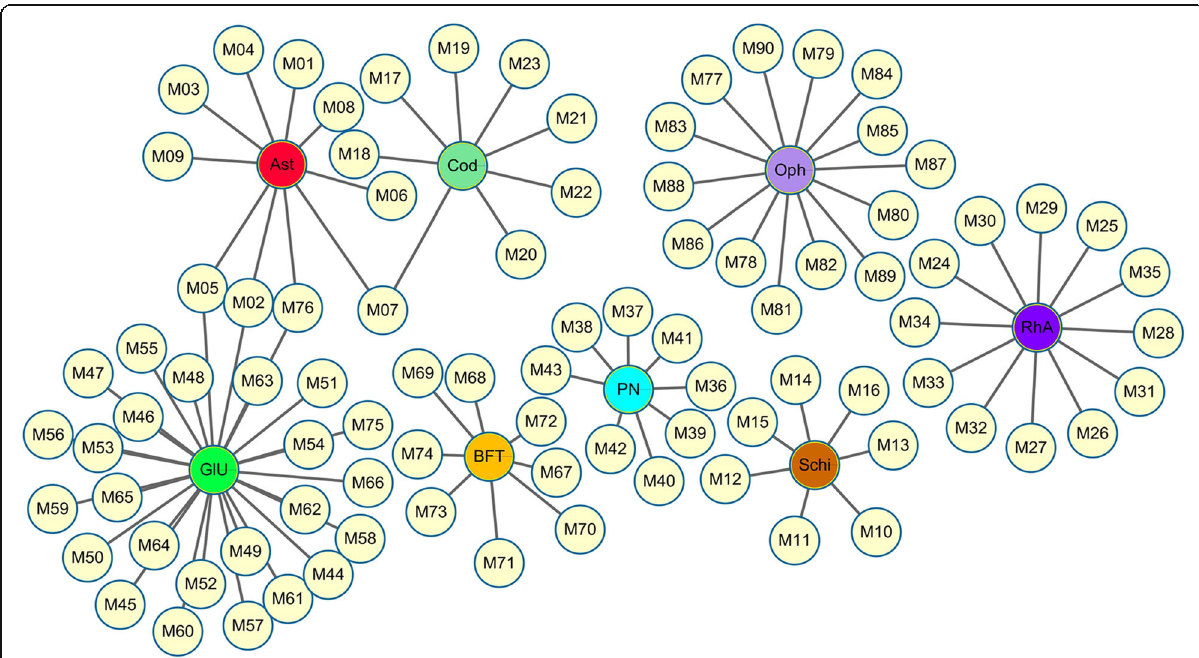
Fig. 4 Compound – medicine network. Yellow circular nodes represent the effective chemical compounds from eight herbs in FFK. Rectangle nodes indicate the following herbs: Astragalus membranaceus (Ast), Codonopsis pilosula (Cod), Ophiopogon japonicus (Oph), Schisandra chinensis (Schi), Panax notoginseng (PN), Bulbus fritillariae thunbergii (BFT), Rhizoma anemarrhenae (RhA), and Glycyrrhiza uralensis